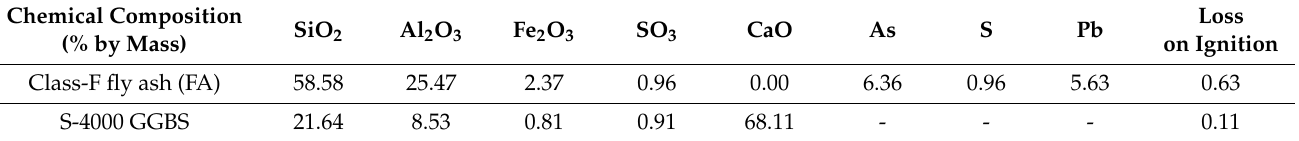
Figure 2. SEM results: ( a ) class-F fly ash (FA); ( b ) S-4000 GGBS. Table 2. Composition of class-F fly ash (FA) and S-4000 GGBFS as determined by XRD (mass %).